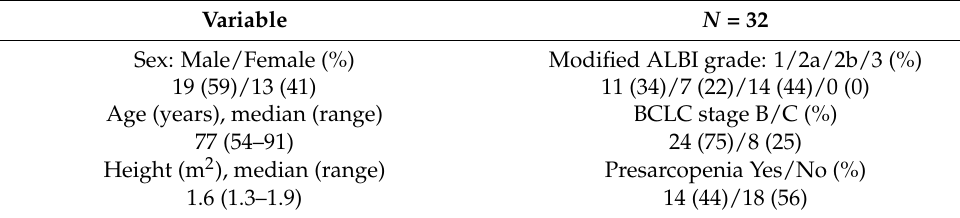
Table 1. Baseline characteristics of the